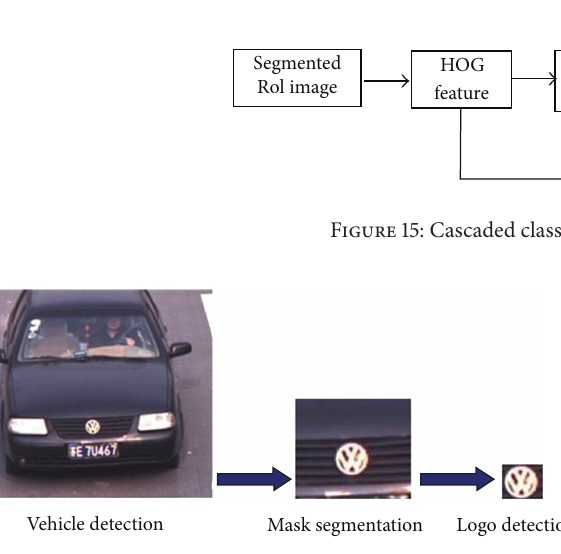
Figure 16: Demonstration of the logo detection